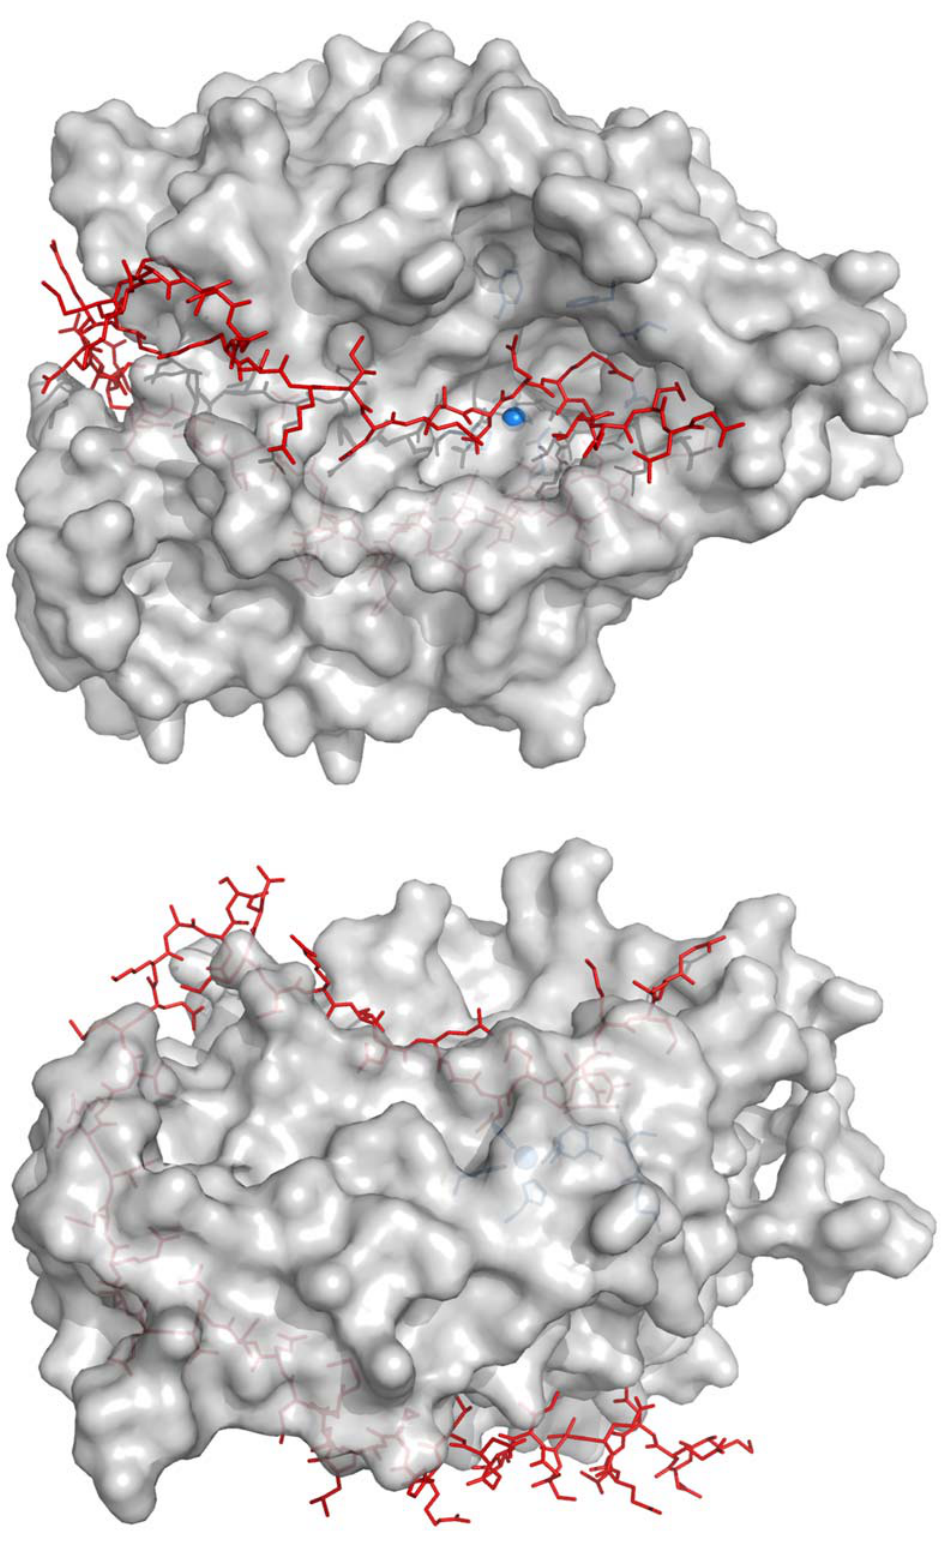
Figure 1. Large enzyme-substrate interface of BoNTAe. A: top view of the active site showing the substrate binding at the large pocket. B: side view of the active site showing the substrate wrapping around the circumference of BoNTAe. Active-site residues of BoNTAe (Zn + 2 , H223, H227, E262, F163, F194, R363, and D370) are shown in light blue sphere or light blue stick model. The SNAP-25 substrate (146–204) is shown in red stick model. BoNTAe is shown in grey surface model with 15% transparency.